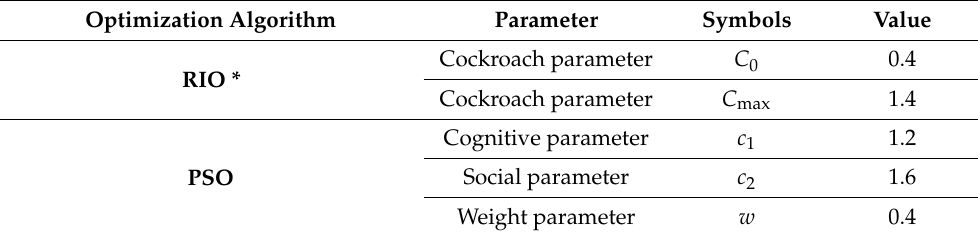
Table 3. Parameters for RIO [46] and PSO [47]